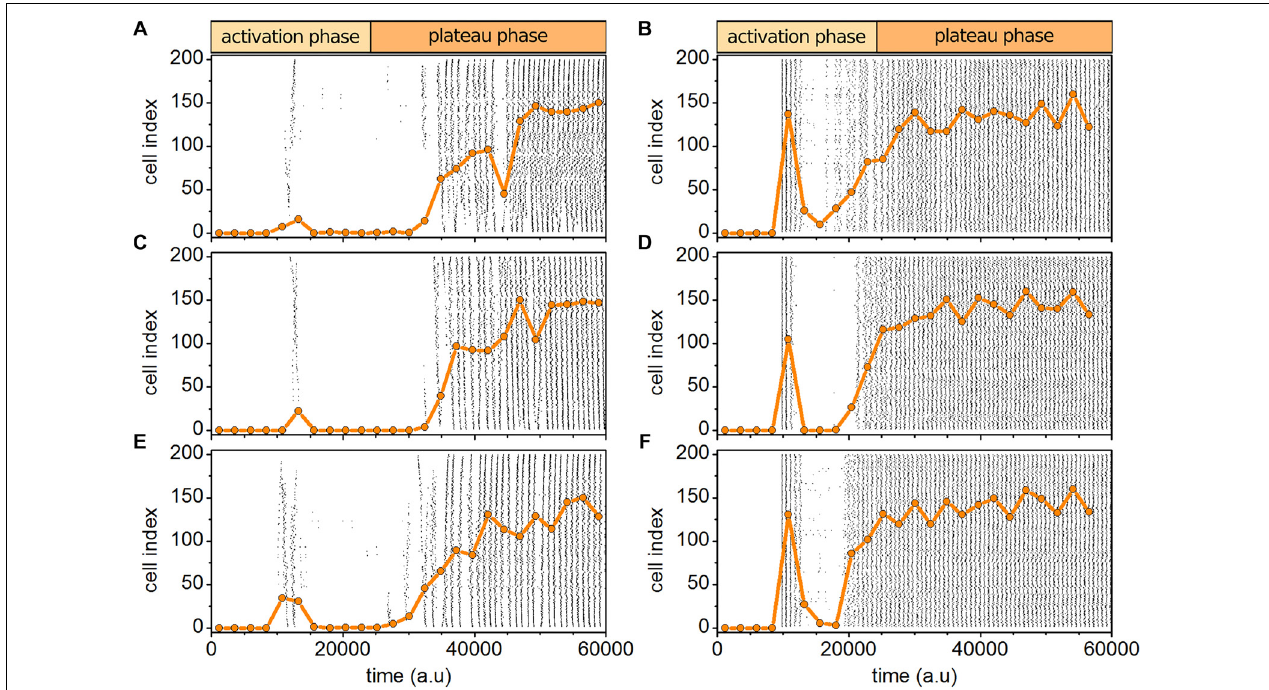
FIGURE 8 | Simulated beta cell responses without particular types of cellular heterogeneities. Behavior without heterogeneity in the intrinsic excitability level (A,B) , without heterogeneity in the delayed responses to stimulation (C,D) , and without heterogeneity in intercellular coupling (E,F) , for both physiological (A,C,E) and supraphysiological (B,D,F) stimulation levels.